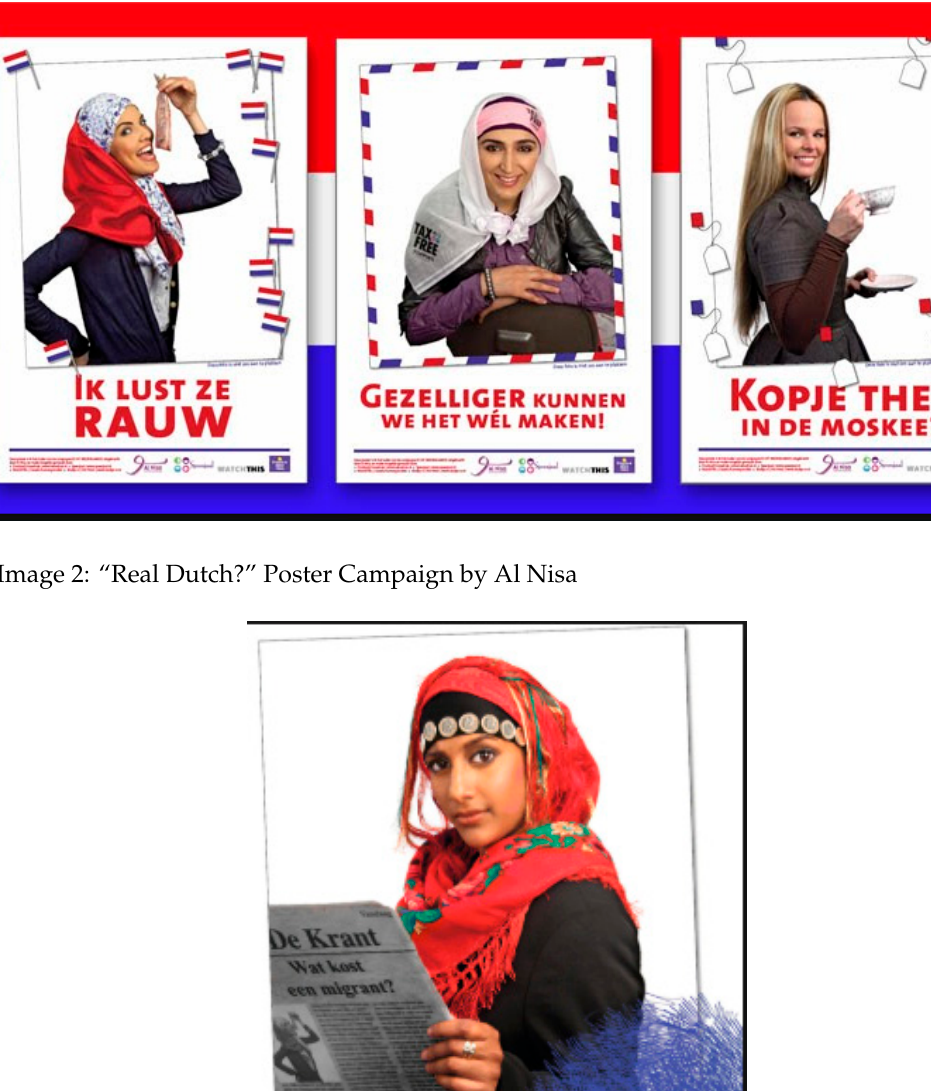
Image 1: “Real Dutch?” Poster Campaign by Al Nisa